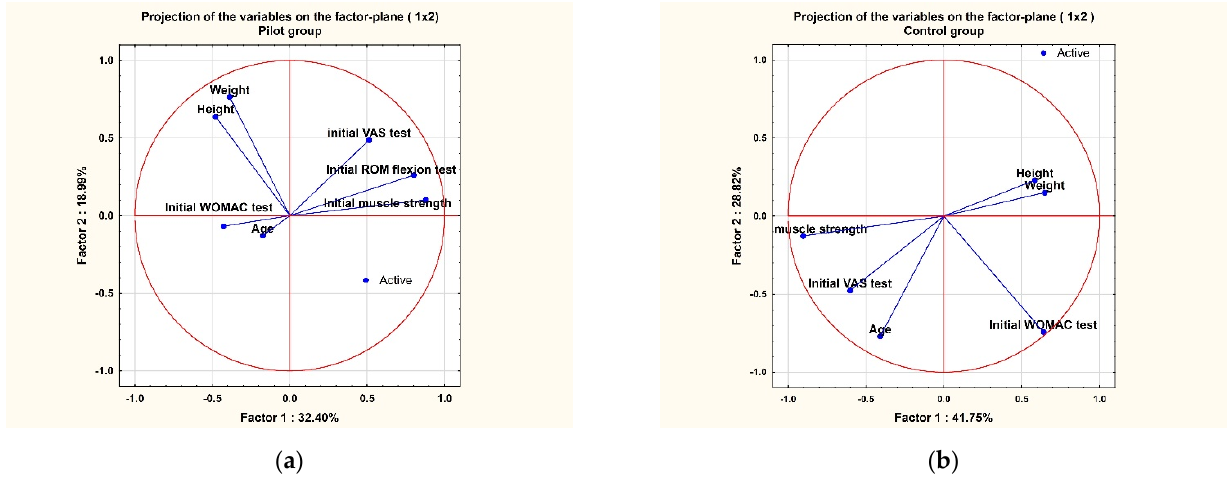
Figure 10. PCA analysis results for the ( a ) pilot group and ( b ) control group at baseline (initial).